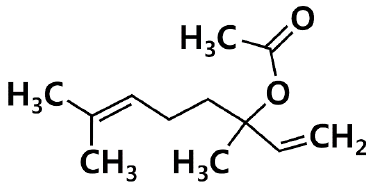
Figure 1. Chemical structure of linalyl acetate (LA).